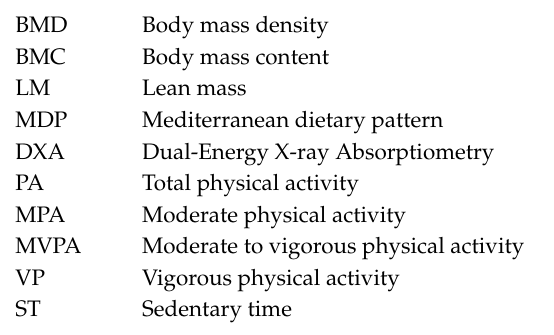
s1, Table S1: Adherence to the Mediterranean dietary pattern (MDP) in boys and girls; Table S2: Descriptive characteristics of the sample by study